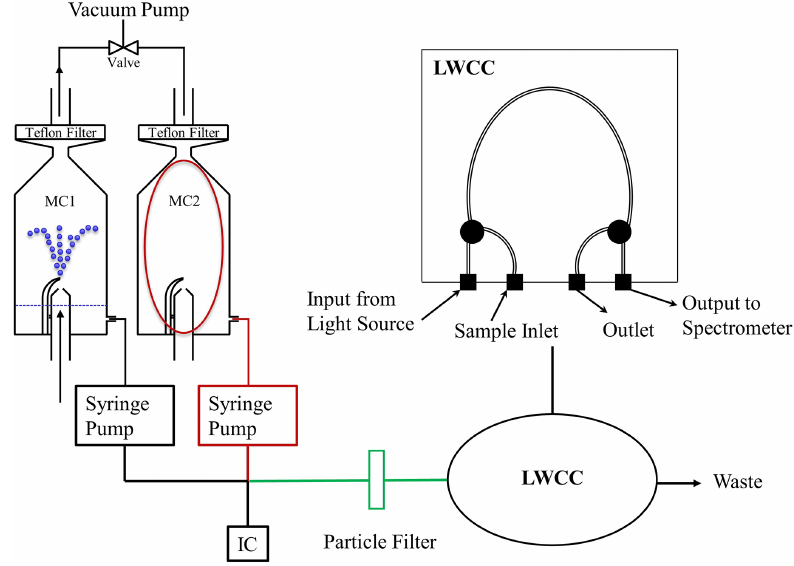
Figure 1. Flow diagram of the MC-LWCC instrument for WS BrC. Blue dots represent the mist generated in the scrubber. Red lines are the first hysteresis components described in Sect. 3.3, and green lines are the second